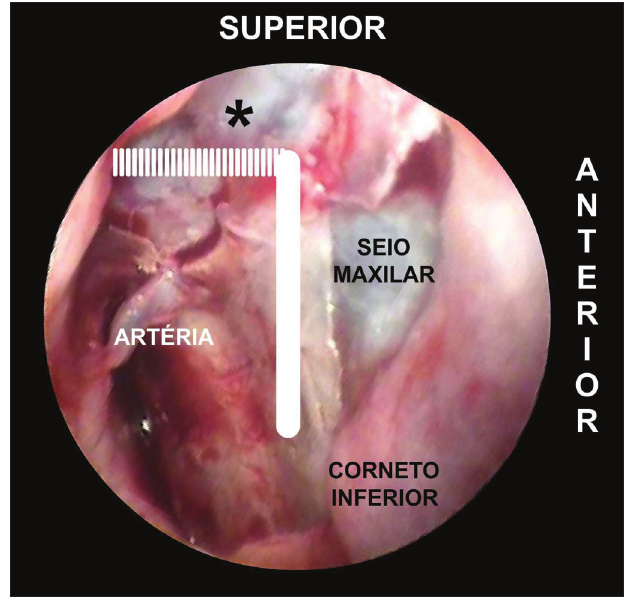
Figura 4. Fotografia da fossa nasal esquerda com detalhes do “quadri - látero esfenopalatino”. O limite superior para se encontrar os